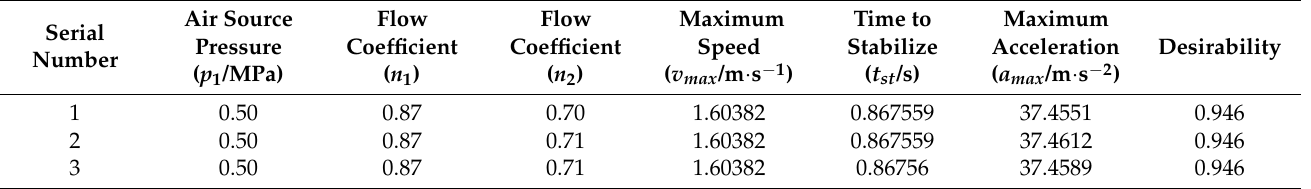
Table 8. Parameter optimization results.